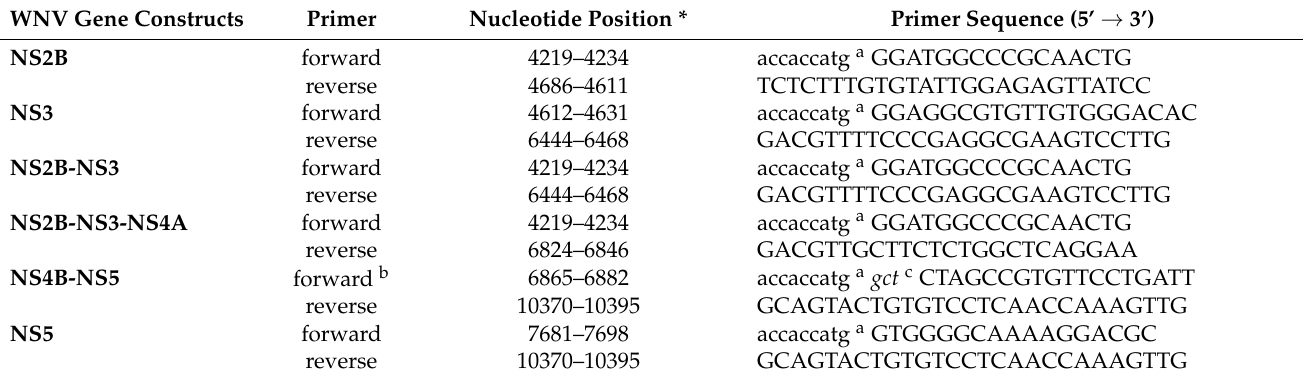
Table 1. Sequences of primers used for the construction of WNV nonstructural (NS) gene constructs. WNV Gene